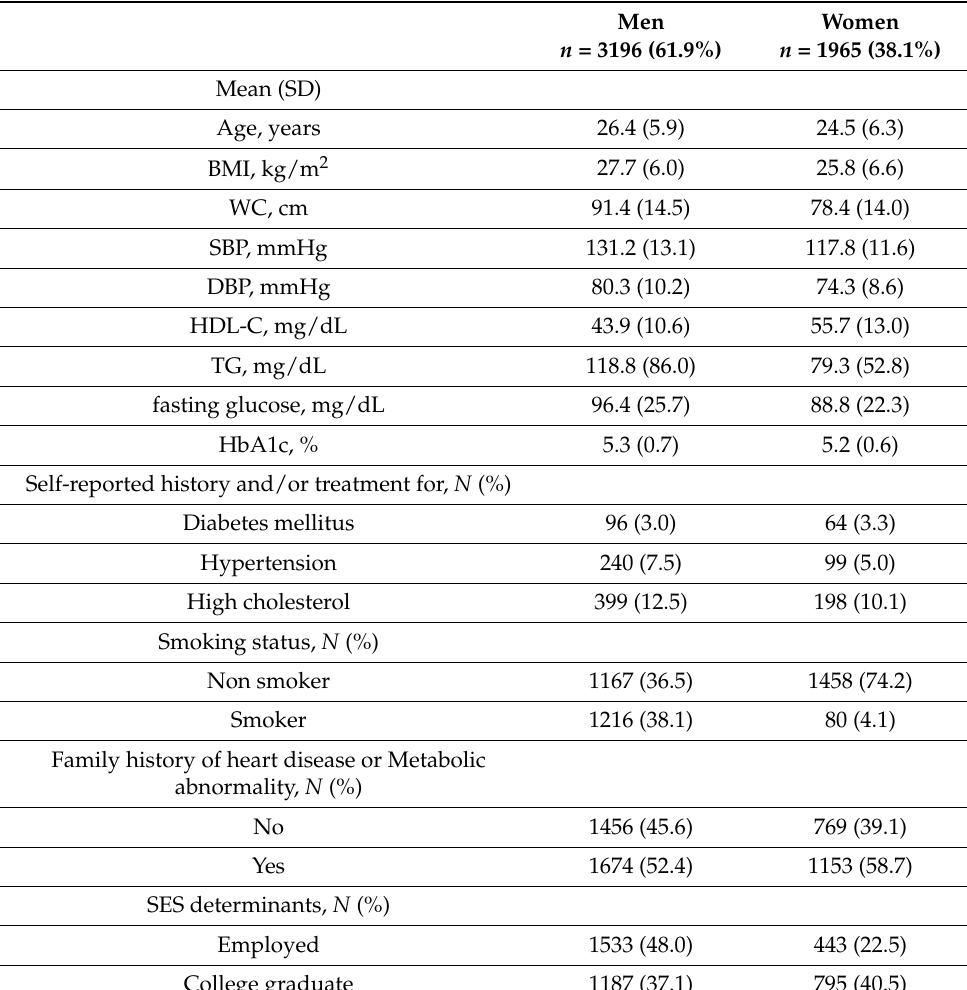
Table 1. General characteristics of the UAEHFS population ( n = 5161).